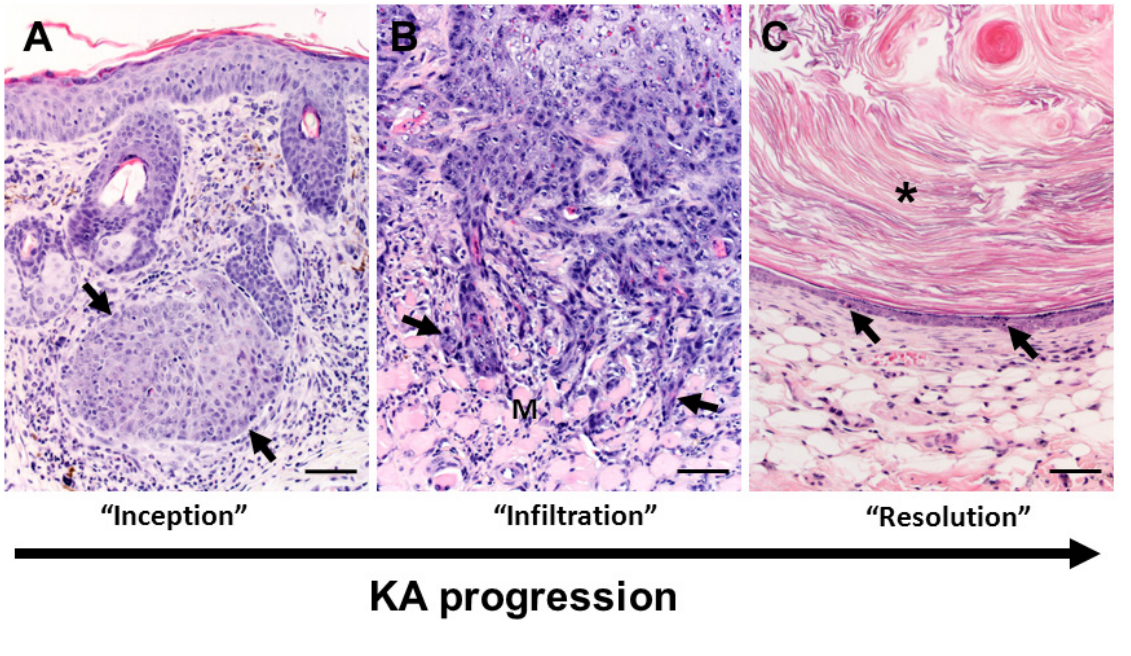
Figure 3. Overview of keratoacanthoma (KA) biology. ( A ) The inception of KA tumors (arrows) occurs in the dermis arising near (in Figure 3A serial sections were not available to confirm continuity with follicle) or from the follicular epithelium. Note: in this tissue section the epidermis is acanthotic (thickened) immediately overlying the tumor with mild dermal inflammation. ( B ) During the “growth” (extending into the “maturation”) phases of KA development, the deep proliferating squamous epithelium can form cellular cords or tongues (arrows) that invade adjacent deeper structures including adipose or skeletal muscle (M) tissues in the panniculus. This example of tumor invasiveness can lead to misdiagnosis of malignant biology. ( C ) In the regression phase, the KA lining epithelium becomes progressively thinner with apoptotic bodies (arrows). As the KA crateriform structure is obscured in regression, the tumor “flattens” into epidermal like structure with smaller mass-like structures often filled by lamellar keratin (asterisk) that resemble benign follicular cysts. Bars = 100